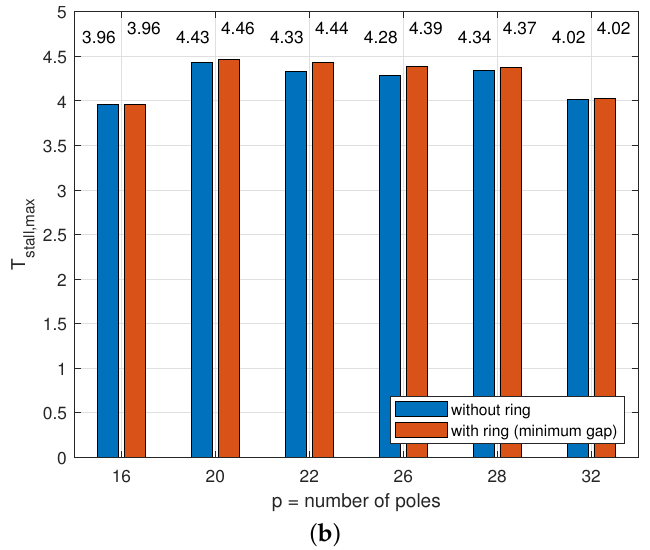
Figure 17. Simulated ( a ) torque derating factor T stall / T uniform,s24p22 and ( b ) maximum stall torque for various slot/pole combinations and for the case without thermal end-winding interconnection and with a thermal end-winding interconnection with a minimum gap between the end-winding and the ring. ( a ) Simulated torque derating factor T stall / T uniform,s24p22 . ( b ) Simulated maximum stall torque (@ T hotspot = 150 ◦